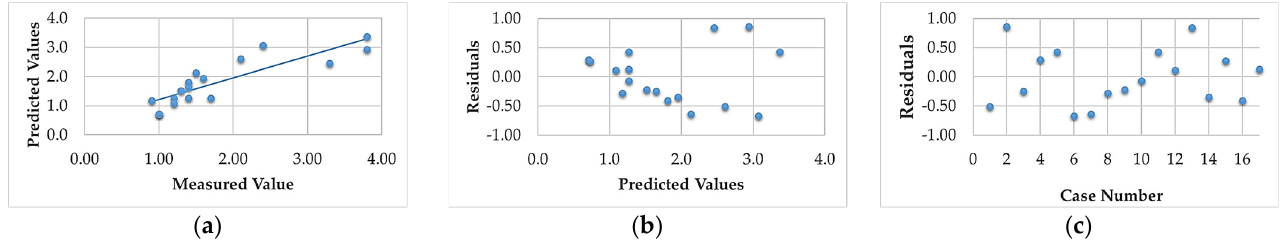
Figure 5. Model checking graphs for surface roughness Sa: ( a ) normal residuals plot; ( b ) residuals versus predicted values; and ( c ) residuals as a function of cases.